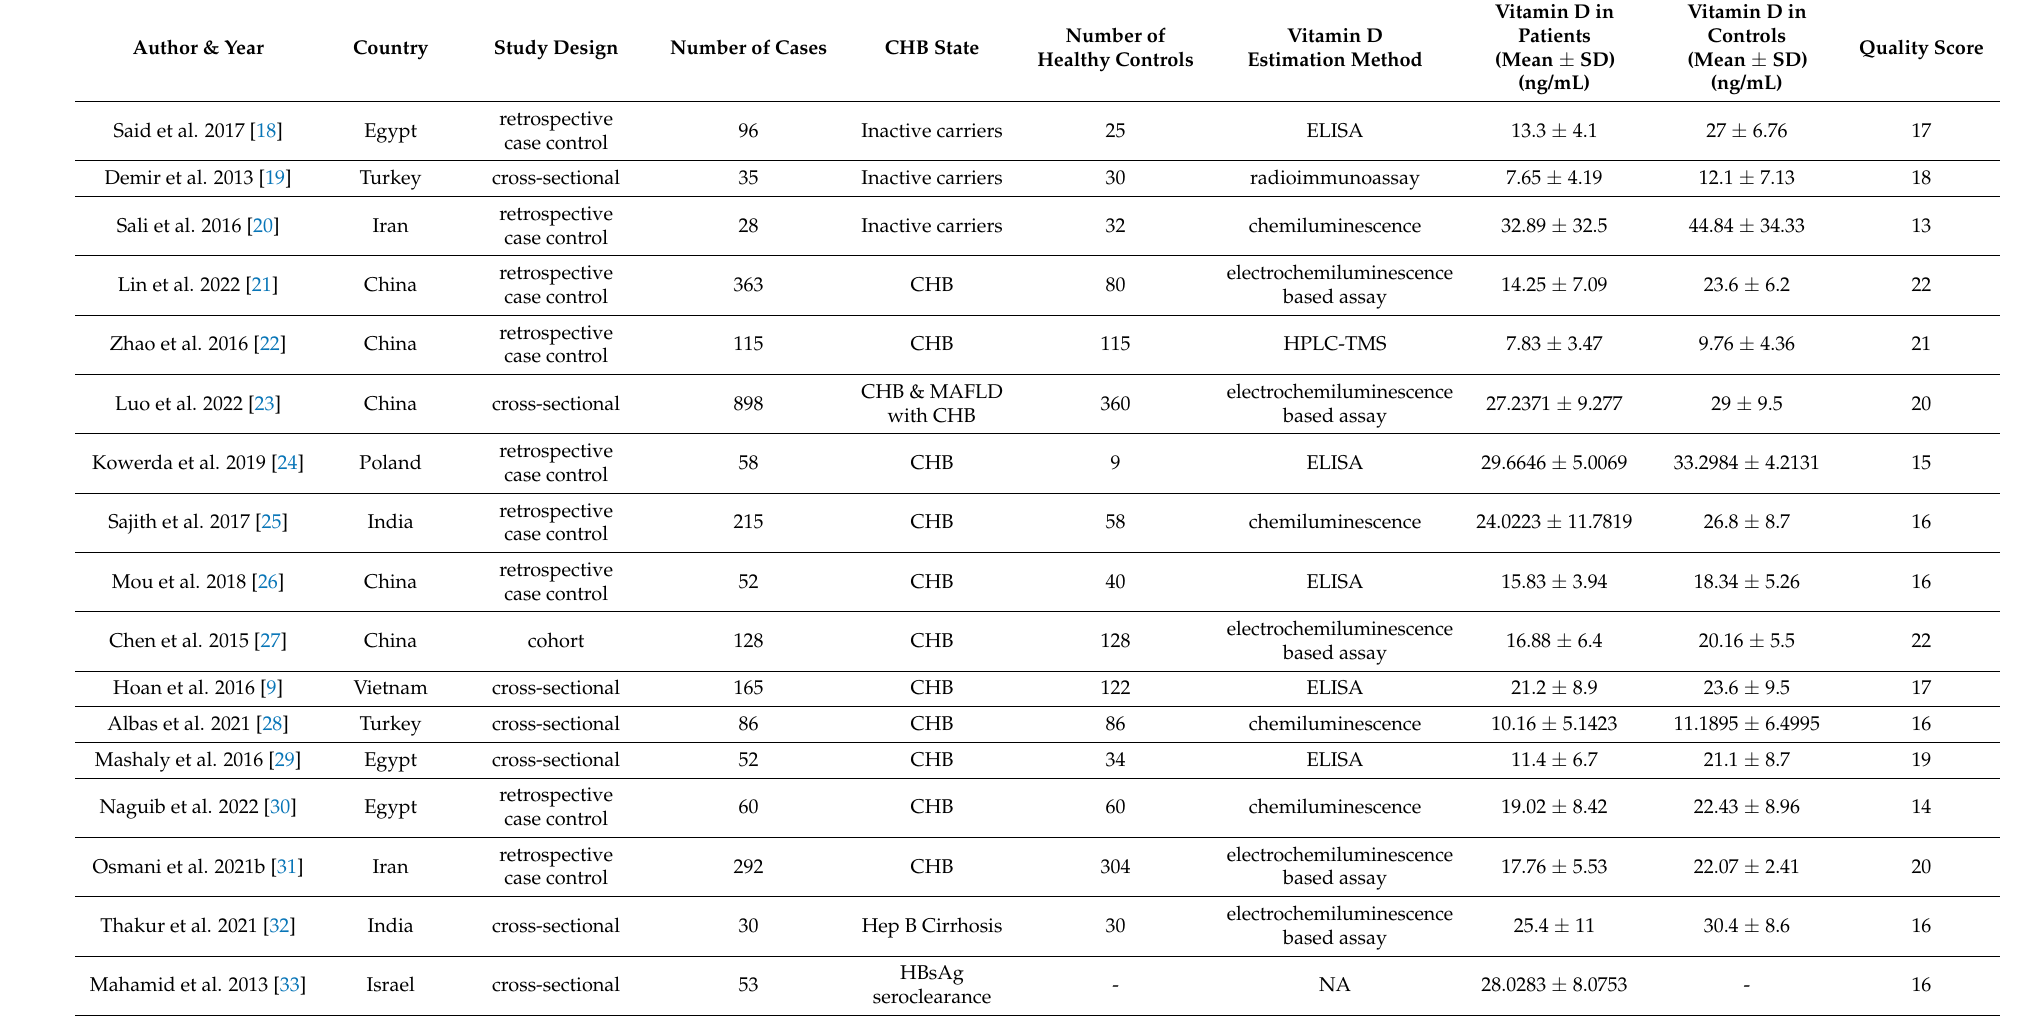
Table 2. Main characteristics of included